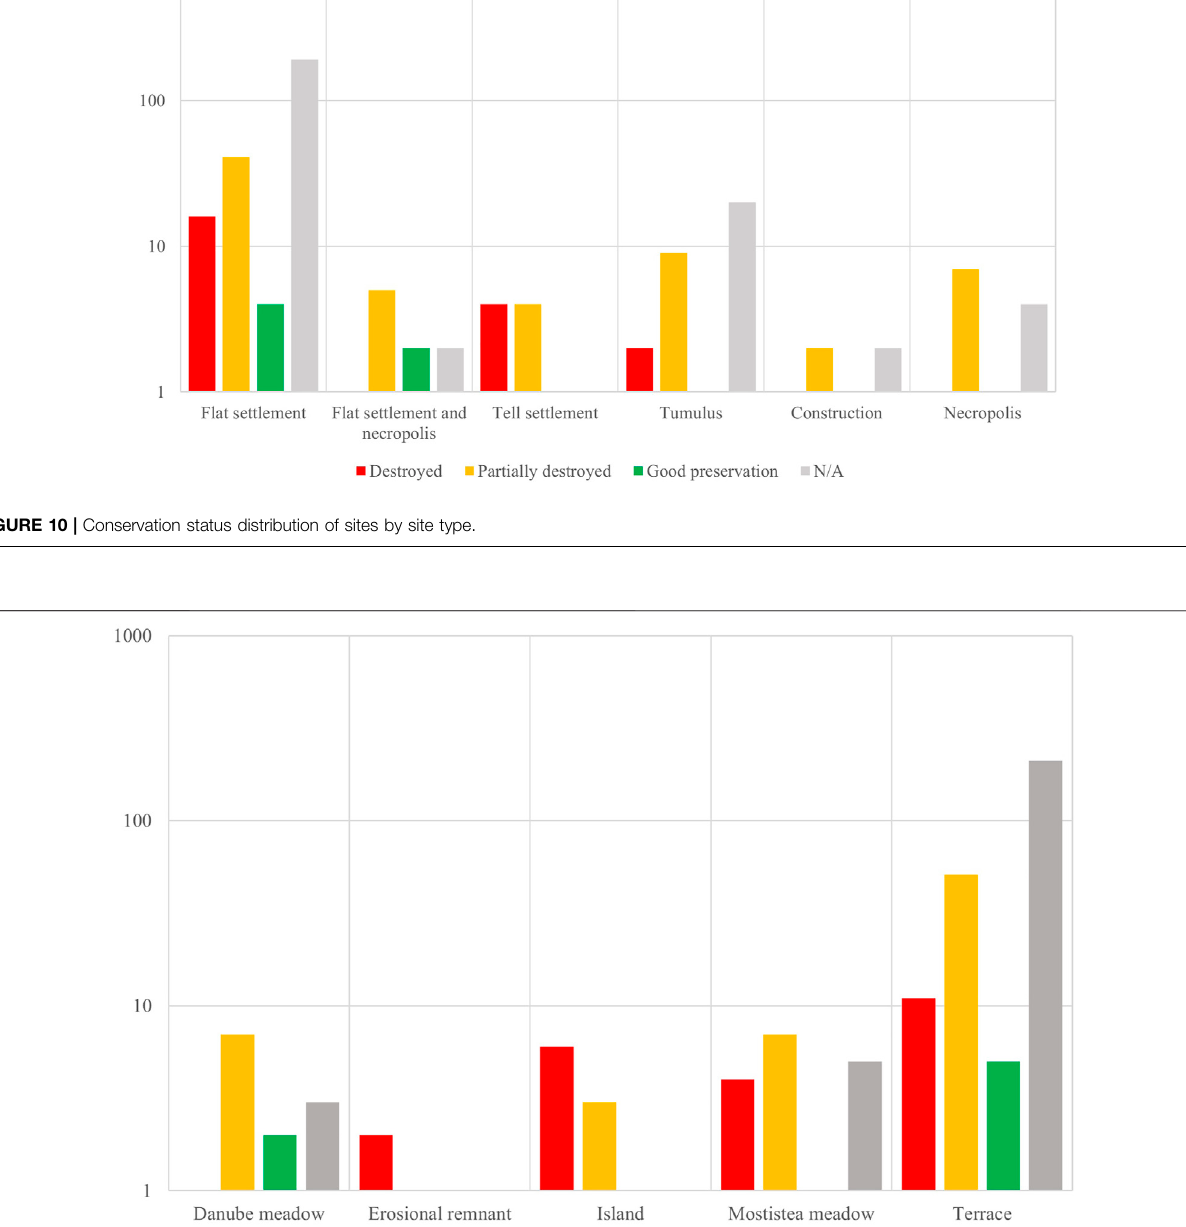
Frontiers in Environmental Science |